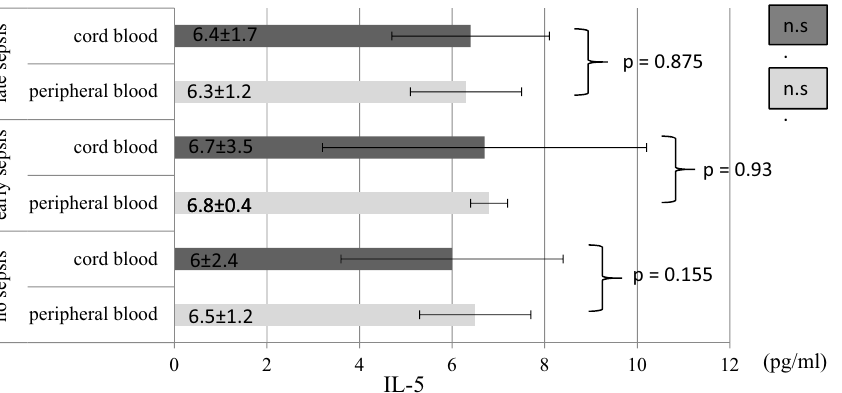
Figure 2: IL - 5 ( pg/mL ) levels in the cord blood and peripheral blood among sepsis subgroups and control group. The plasma levels of IL - 5 was evaluated as described in Material and methods section. Data were expressed as mean ± SD. Abbreviations: no sepsis – participants without sepsis development; early sepsis – participants who developed sepsis in fi rst 72 h of life; late sepsis – participants who developed sepsis after 72 h of life; n.s. – non - signi fi